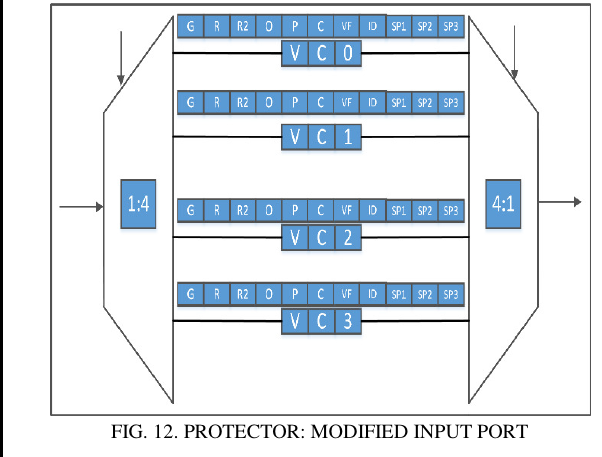
FIG. 12. PROTECTOR: MODIFIED INPUT PORT 4.5 Protector: SA